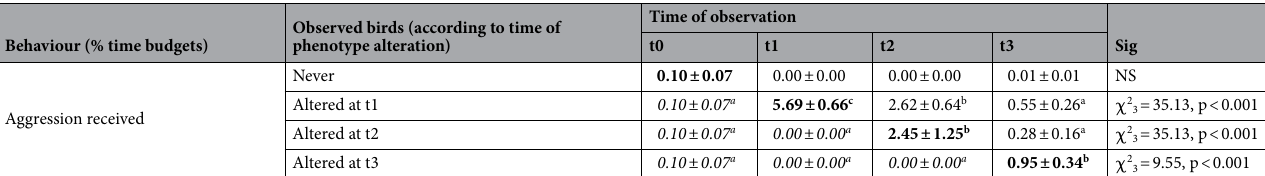
Table 1. Effects of time on the behaviour of birds living in groups subjected to sequential phenotype alteration (originally homogeneous 100M and 100U groups, altered by marking or unmarking). Hens were grouped for the analyses according to their phenotype history as: never altered, altered at t1 (34 weeks of age), altered at t2 (38 weeks of age) and altered at t3 (44 weeks of age). Times of observation: t0 = 27–28 weeks (before any alterations occurred); t1 = 35–36 weeks (after 1st phenotype alteration); t2 = 39–40 weeks (after 2nd phenotype alteration); t3 = 45–46 weeks (after 3rd phenotype alteration). Data are presented as means ± standard errors or ilink estimates ± standard errors, according to the statistical analyses performed for each behaviour. Different letters within the same row indicate significant differences among times of observation at p < 0.05. Bold values highlight the behaviour of recently altered birds at each time period (recently marked or unmarked). Italic values represent the behaviour of birds yet to undergo phenotype alteration, to aid the visualization of the significant differences across time